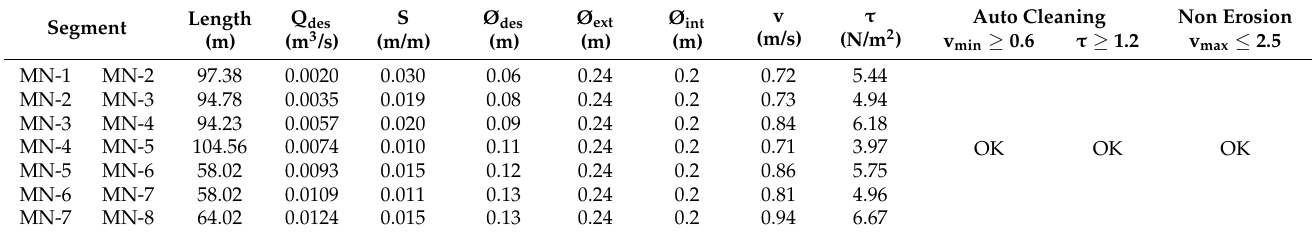
Table 8. Design of the sewerage system in expansion zone 1.